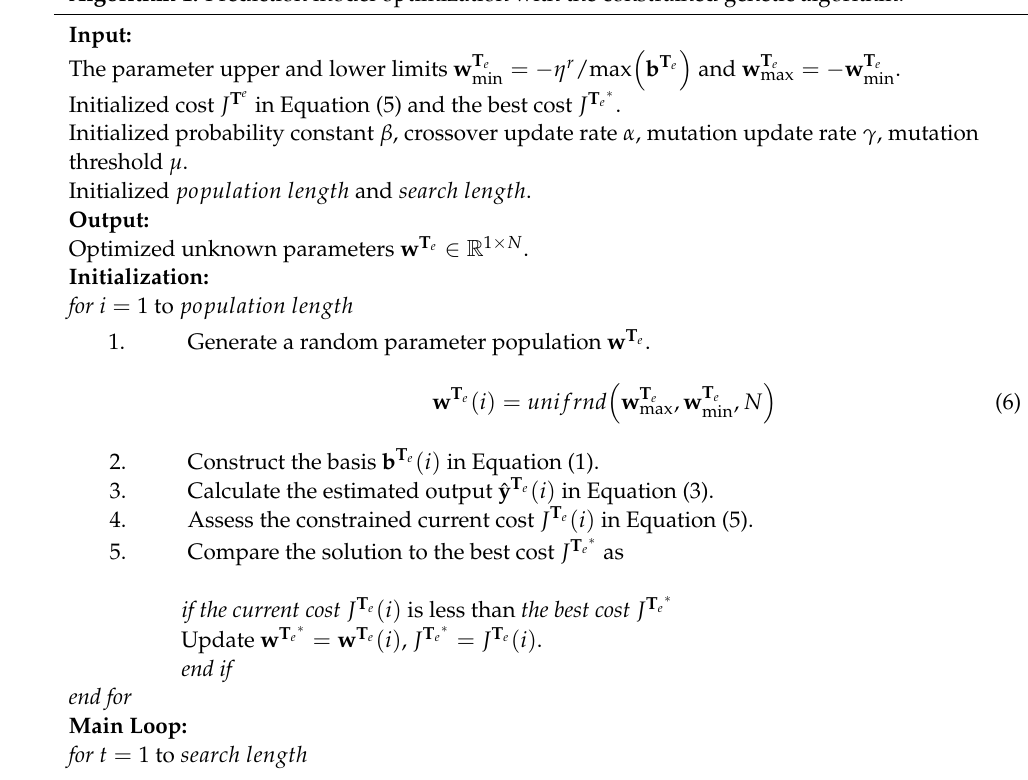
Algorithm 1: Prediction model optimization with the constrained genetic